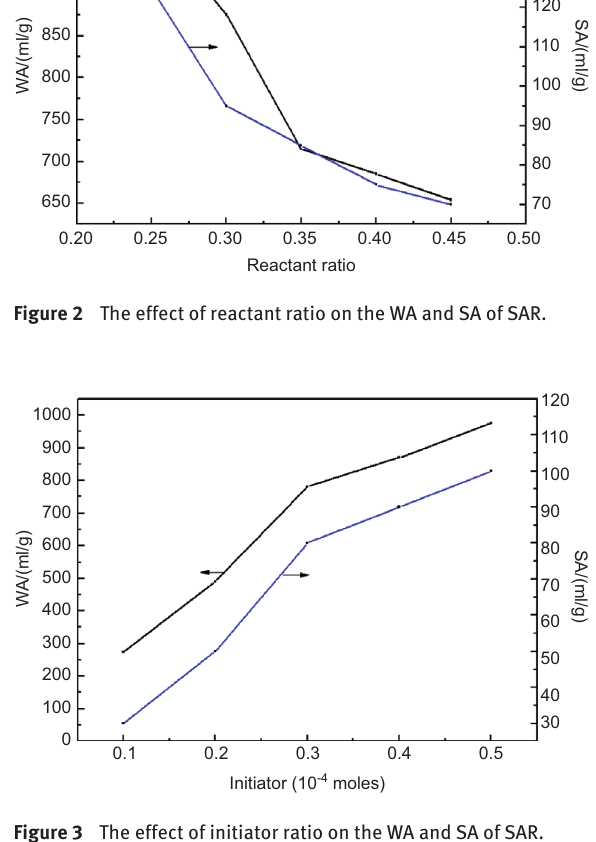
Figure 3 The effect of initiator ratio on the WA and SA of SAR.